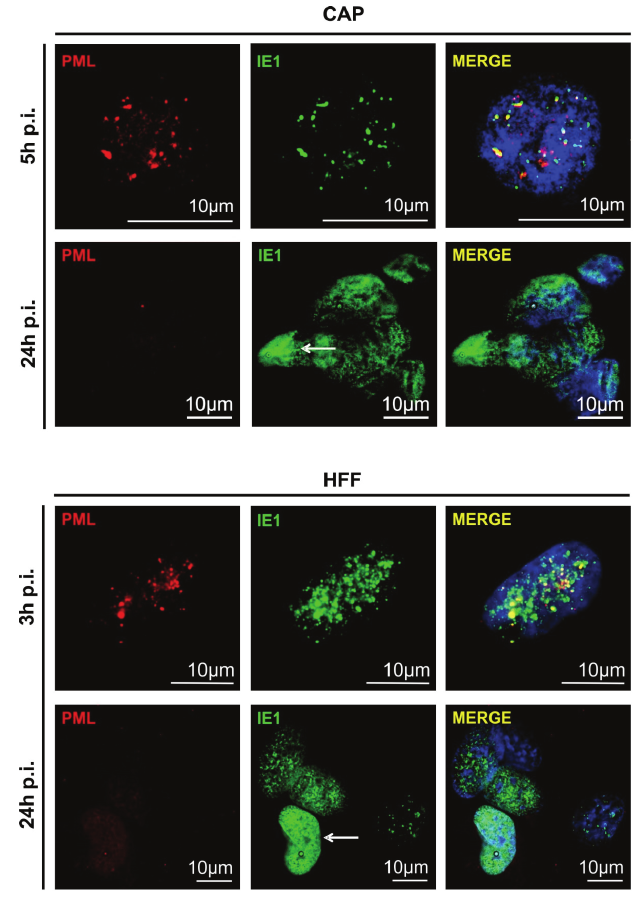
Figure 3. IF-analysis of the IE1-colocalization with and the subsequent dispersal of PML-bodies in CAP adh. and HFF (control). Cells were infected with TB40/E-BAC7 at an m.o.i. of 2. Infected HFF were taken along as control. After 5 and 24 h (CAP adh. , upper panel) or 3 and 24 h (HFF, lower panel) of infection, samples were collected and subjected to IF-analysis using the IE1-specific monoclonal antibody p63-27 as well as a rabbit polyclonal antibody directed against PML. p63-27 binding was detected with an Alexa Fluor 488 labeled secondary antibody (green). PML was detected with an Alexa Fluor 546 labelled secondary antibody (red). For staining of the nuclei, DAPI (blue) was added to the samples. White arrows point to IE1-stained nuclei after dispersal of PML bodies.